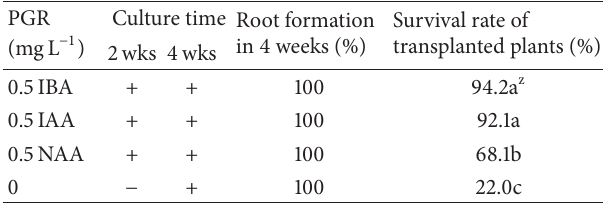
Table 3: Influence of different auxins and activated charcoal on rooting and plantlet survival of L. serratu